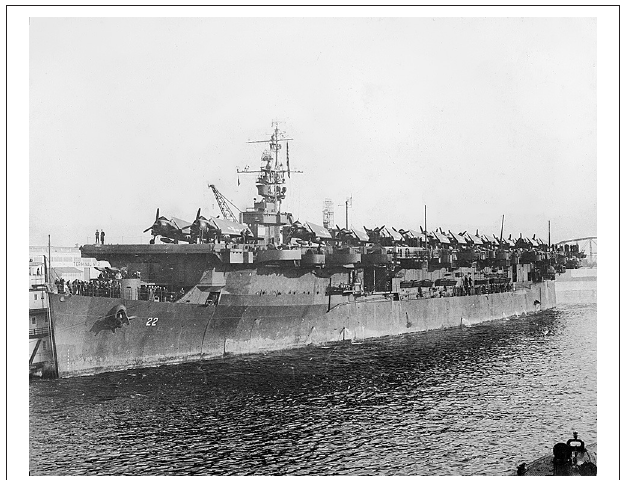
FIGURE 1 | USS Independence in harbor, c. 1943 (U.S. National Archives).